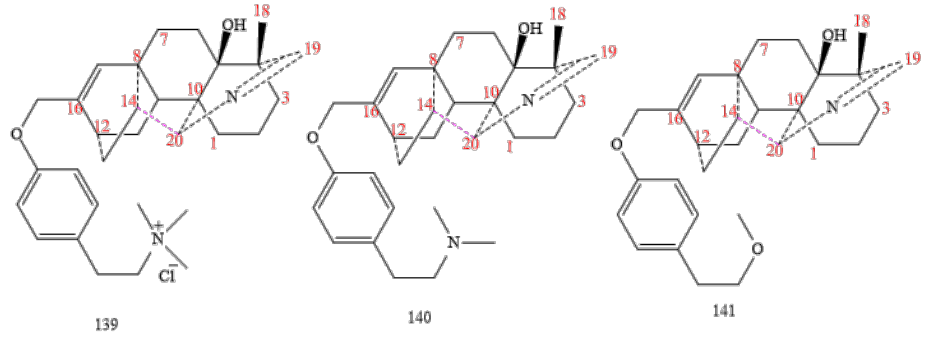
Figure 16. C 20 -hetidine DAs.